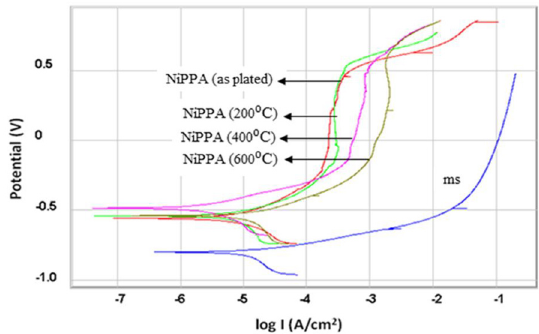
Figure 8. Anodic polarization curves for ms and NiPPA coatings (as plated and heat treated) in 3.5% NaCl solution.